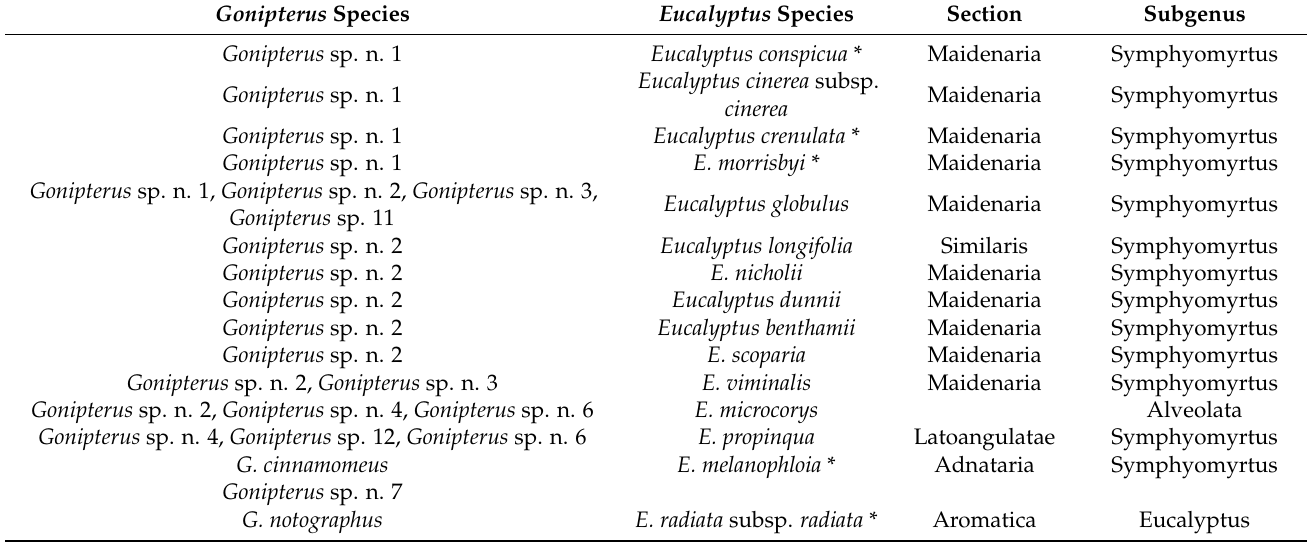
Table 2. Eucalyptus species and their associated Gonipterus species. Classification of Eucalyptus species according to